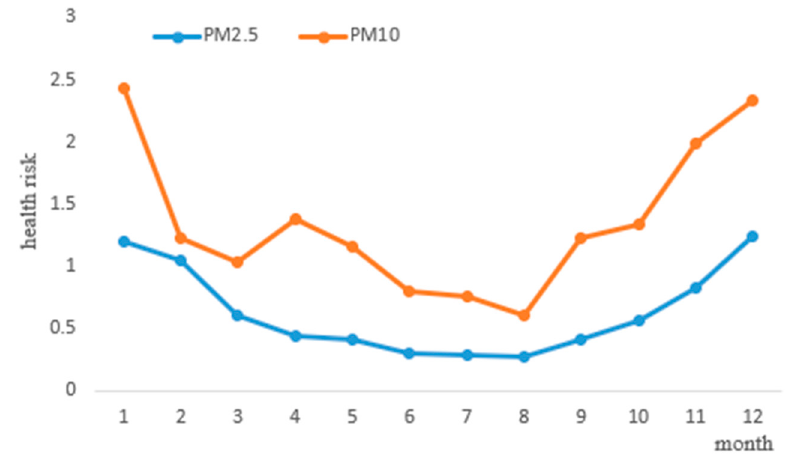
Figure 6. The health risk assessment values of PM 2.5 and PM 10 .